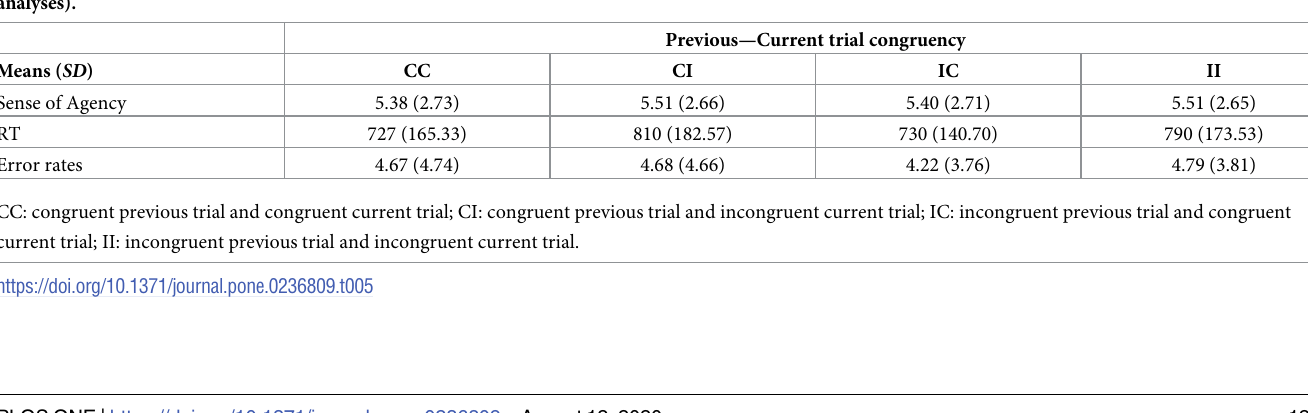
Table 5. Means (SD) for sense of agency (rating from 1 to 9), RTs (in ms) and error rates (in %) in relation to current and previous congruency (trial-by-trial analyses). Means ( SD ) Sense of Agency